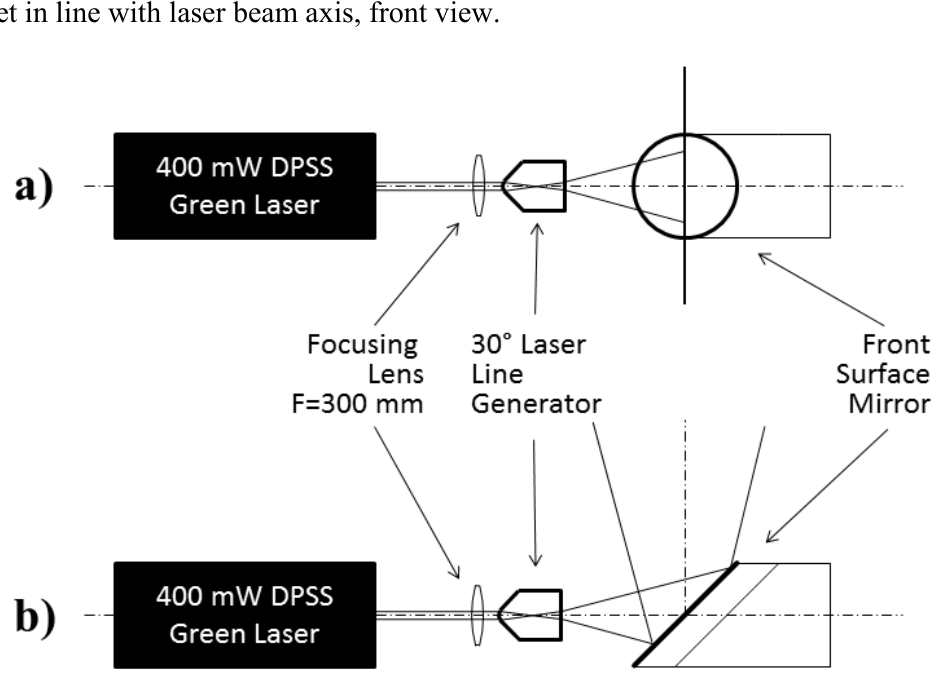
Figure 2. Laser light sheet generator setup: ( a ) Sheet across the laser beam axis, top view; ( b ) Sheet in line with laser beam axis, front